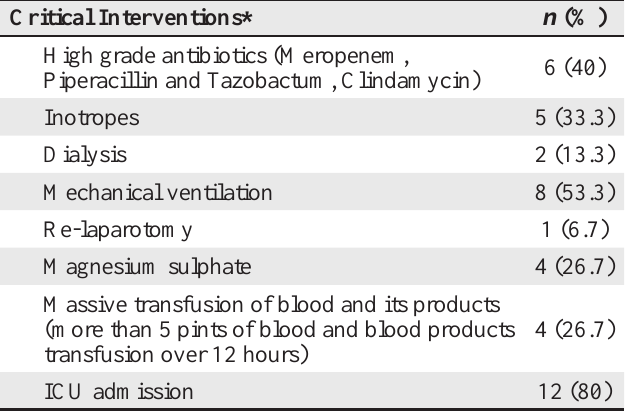
Table 5 : Critical intervention provided in maternal deaths